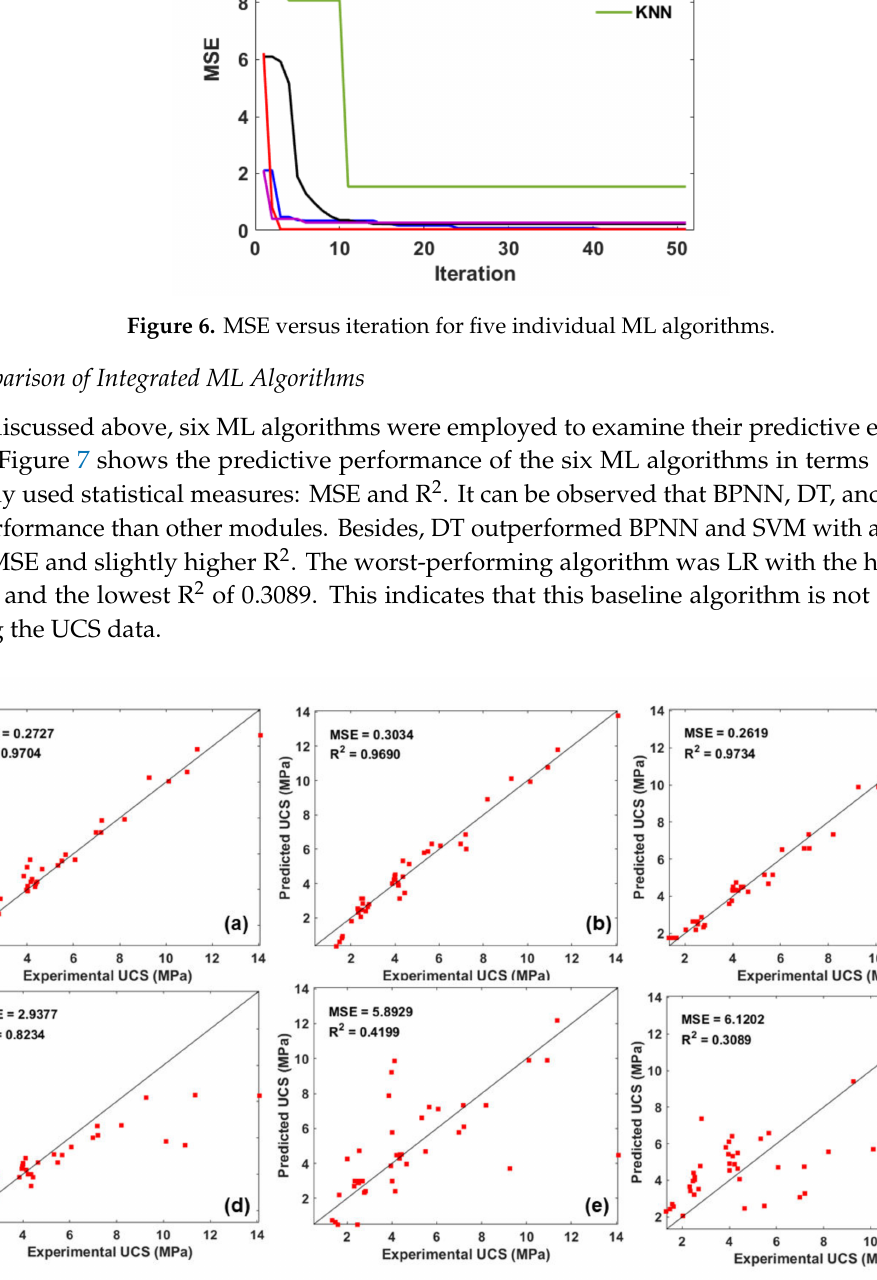
Figure 7. Predicted and actual UCS in the test dataset: ( a ) BPNN, ( b ) SVM, ( c ) DT, ( d ) RF, ( e ) KNN, ( f )